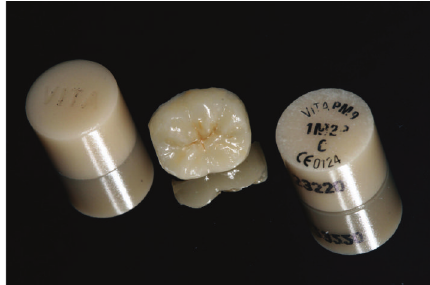
Figure 6: The monolithic ceramic endocrown after customization with the VITA AKZENT Plus system.